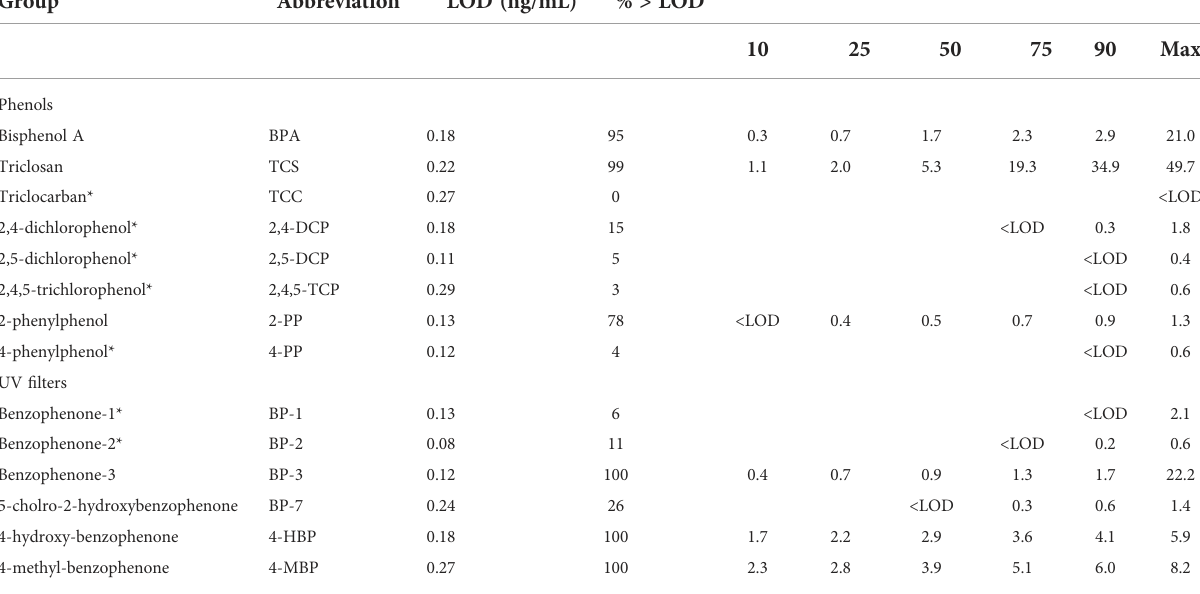
TABLE 1 Chemical names, abbreviations, LODs (limit of detection) and serum concentrations of phenols and benzophenones in 100 prenatal serum samples (percentiles).